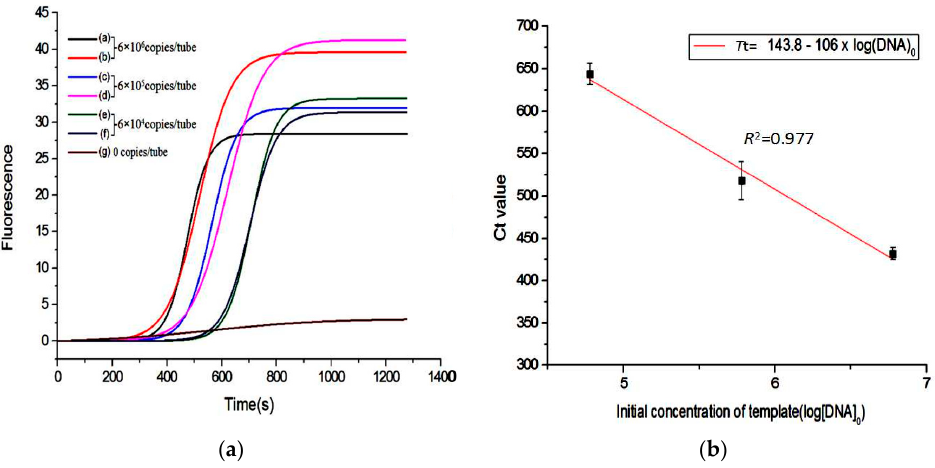
Figure 5. ( a ) The amplification plot with reaction time and fluorescence intensity; ( b ) the standard curve with the average of T t values against the logarithm of the corresponding three different initial DNA concentrations.